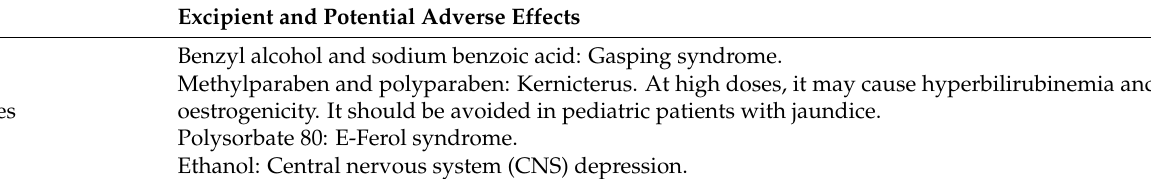
Table 3. Pharmaceutical excipients and potential adverse effects related to their use [29,30,36,38,50–53].